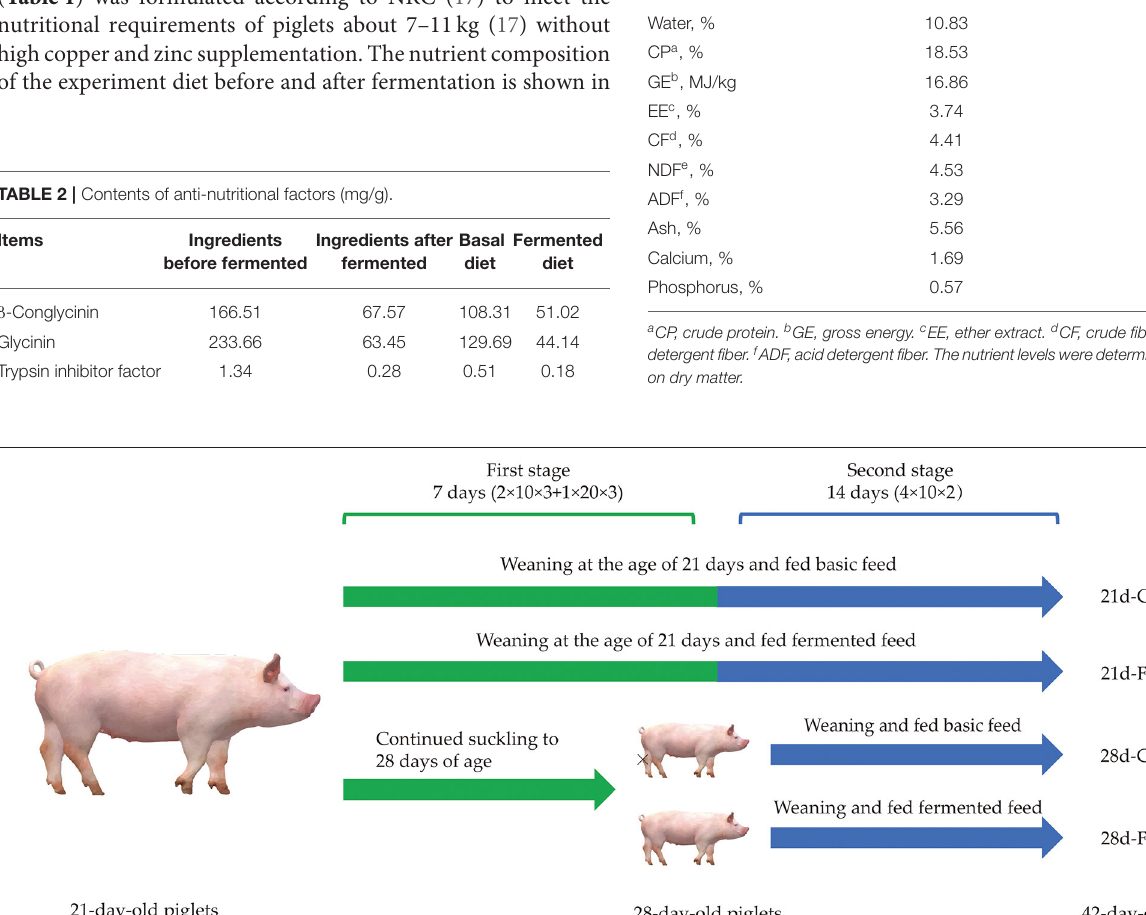
FIGURE 1 | Diagram of the experimental design. Six 21-day-old piglets with similar body weight were randomly selected from the same litter of 20 sows, and then three of them were randomly selected as a replicate and to be weaned immediately, and the others continue to suckle until 28 days old before weaning. As soon as weaned, the piglets were randomly allocated into two treatments, fed with basal diet as the control group and fermented diet as the fermented group, respectively. The experiment was finished at the age of 42 days old. 21d-CD, 21-day-old weaned piglets fed the control diet. 21d-FD, 21-day-old weaned piglets fed the fermented diet. 28d-CD, 28-day-old weaned piglets fed the control diet. 28d-FD, 28-day-old weaned piglet fed the fermented diet. The same as below.